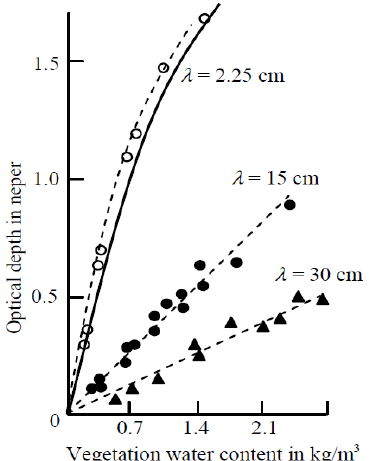
Figure 10. Dependence of optical depth on PWC. Solid curve is calculated by the model of Equation (1) (After [10]).